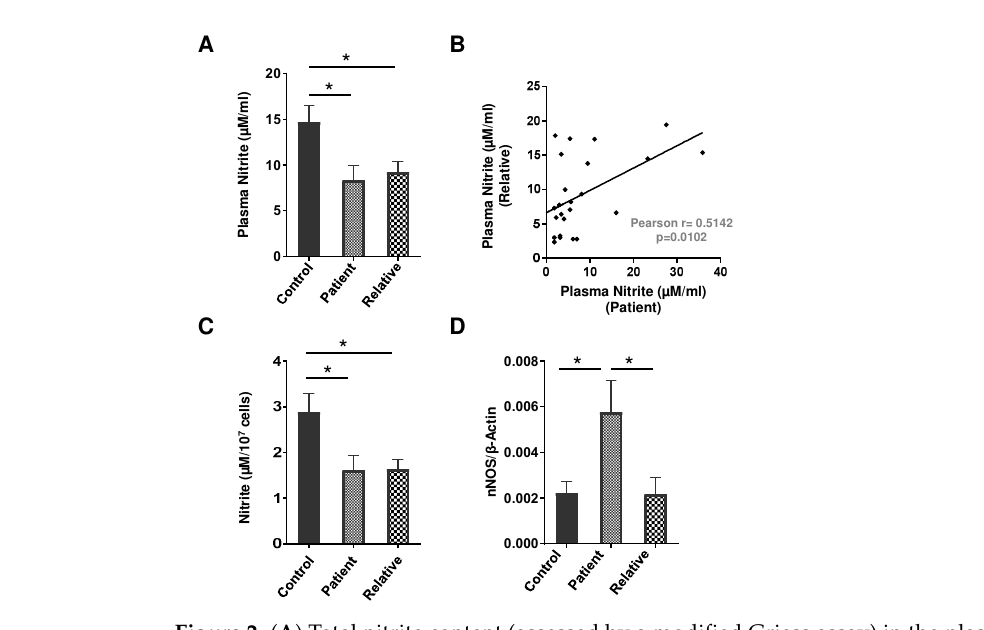
Figure 2. ( A ) Total nitrite content (assessed by a modified Griess assay) in the plasma of drug-naive depression patients ( n = 27), their first-degree relatives ( n = 24), and healthy volunteers ( n = 26). F (2, 74) = 4.953; * p < 0.05. ( B ) Correlations in the plasma nitrite content between depressive patients and their first-degree relatives. ( C ) Total nitrite content (assessed by a modified Griess assay, healthy controls n = 27, depression patients and first-degree relatives, n = 18 in every group) F (2, 60) = 4.422; * p < 0.05, and ( D ) nNOS mRNA expression as analyzed by a real-time PCR using β-Actin as an internal loading control in the PMNs of drug-naive depression patients, their first-degree relatives, and healthy volunteers (depression patients n = 22, first-degree relatives n = 21, healthy controls n = 22). F (2, 62) = 4.709; * p < 0.05. ( A , C , D ) Data expressed as mean ± SEM.